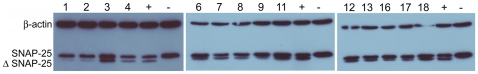

In vitro tissue culture assay to discover potential inhibitory activities of our sdAb clones.Neuro-2A assay demonstrating the ability of some of the anti-A BoNT sdAb to inhibit the process of BoNT intoxication by reducing the intracellular cleavage of SNAP-25. + indicates toxin without sdAb and – indicates no toxin and no sdAb.